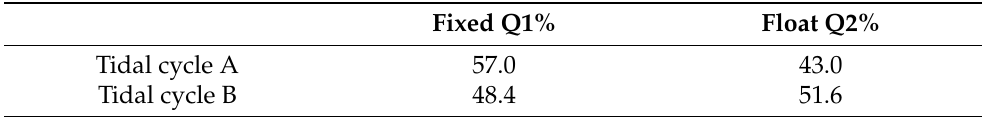
Table 3. Percentage of fixed and float